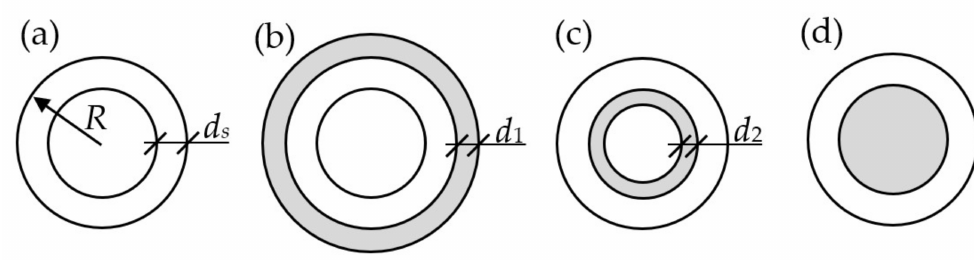
Figure 5. Versions of the considered cross-section of the rod. ( a ) the cross-section of rod - dome 1; ( b ) the cross-section of rod - dome 2; ( c ) the cross-section of rod - dome 3; ( d ) the cross-section of rod – dome 4 LR.